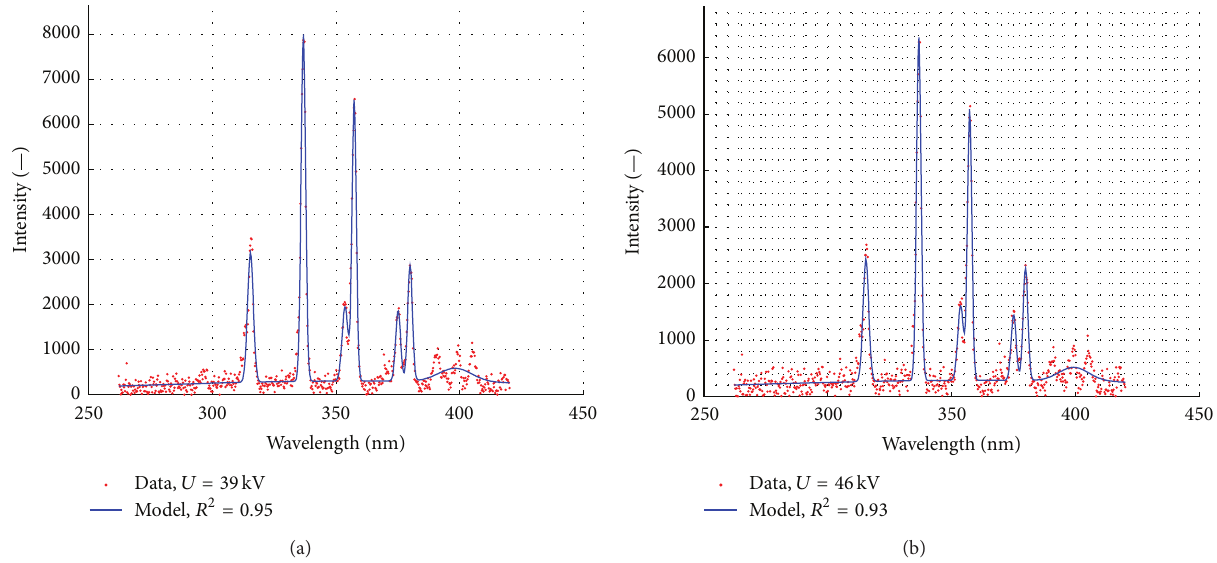
Figure 21: Intensity spectra of recorded and modeled light emission for selected values of PD generation voltages: (a) 0.81 𝑈 𝑝 = 39 kV and (b) 0.95 𝑈 𝑝 = 46 kV.